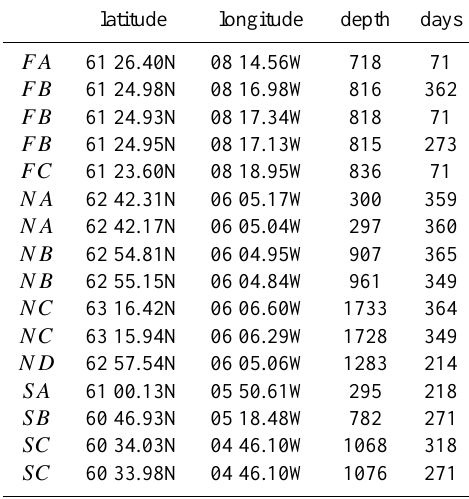
Table 1. Latitude and longitude (degrees), sea-floor depth (in meters) and number of days available for the ADCP time series recorded during the VEINS